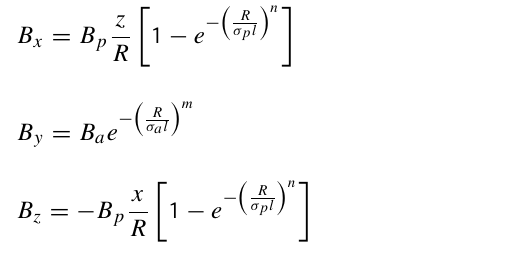
where ( B x 0 model , B y 0 model , B z 0 model ) represents the model field rotated into GSM coordinates using θ and ρ , ( B x 0 data , B y 0 data , B z 0 data ) the data from FGM and B res the